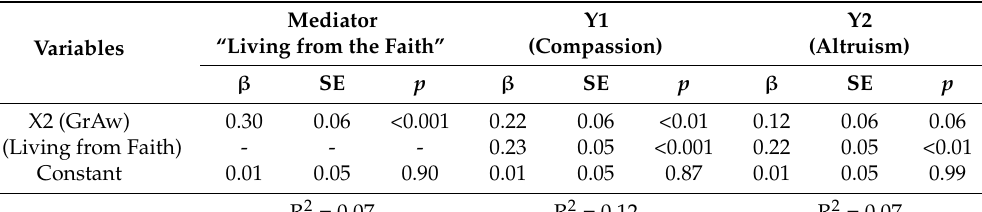
Table 8. Model coefficients for Compassion and Altruism mediated by “Living from the Faith” and Gratitude/Awe (GrA was used as a regressor).